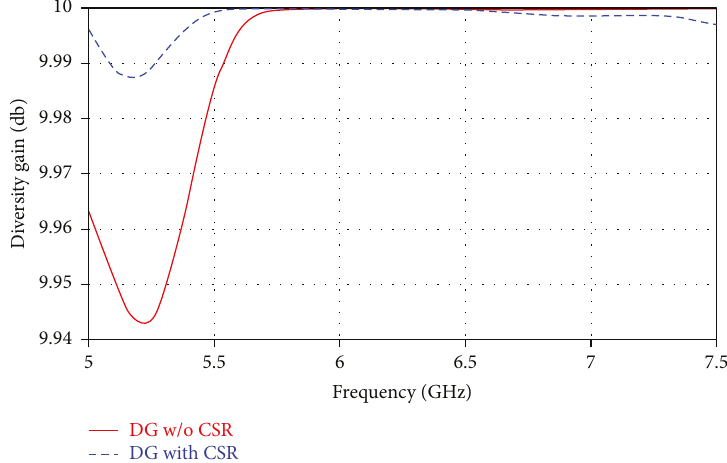
Figure 21: DG of the orthogonal MIMO system with and without MTM-CSR matrix structure.